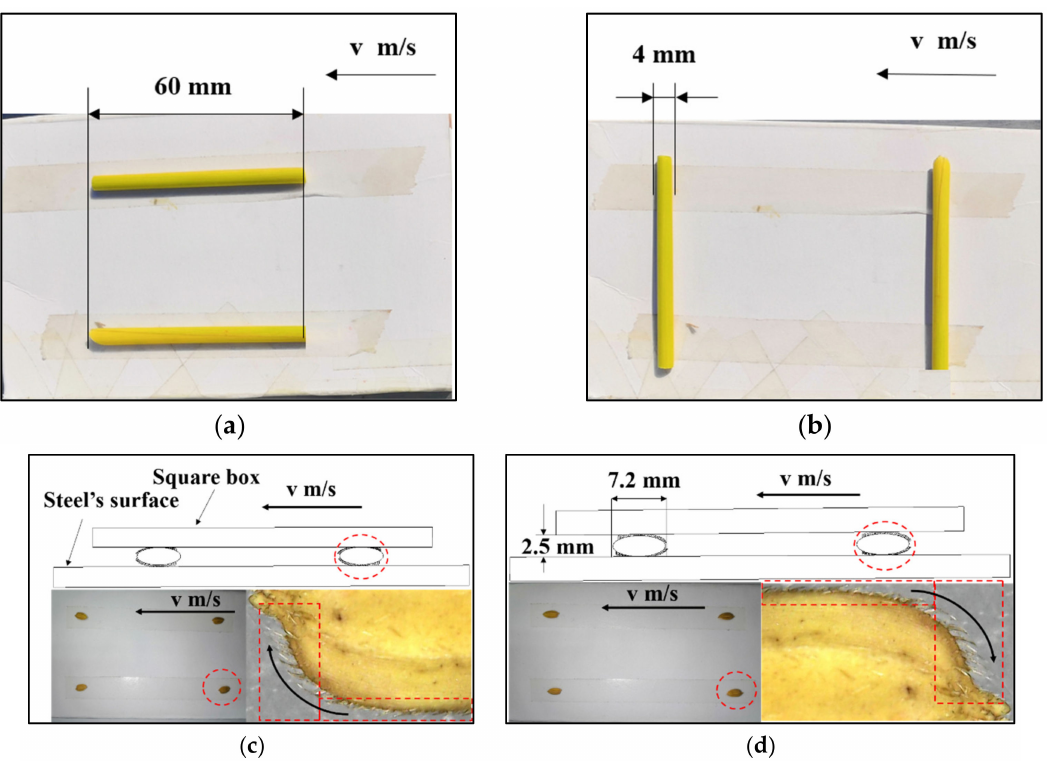
Figure 2. Sampling procedure for measuring the friction coefficient: ( a ) the stem is placed parallel to the movement direction; ( b ) the stem is placed perpendicular to the movement direction; ( c ) the awn points away from the movement direction; ( d ) the awn points in the movement direction.